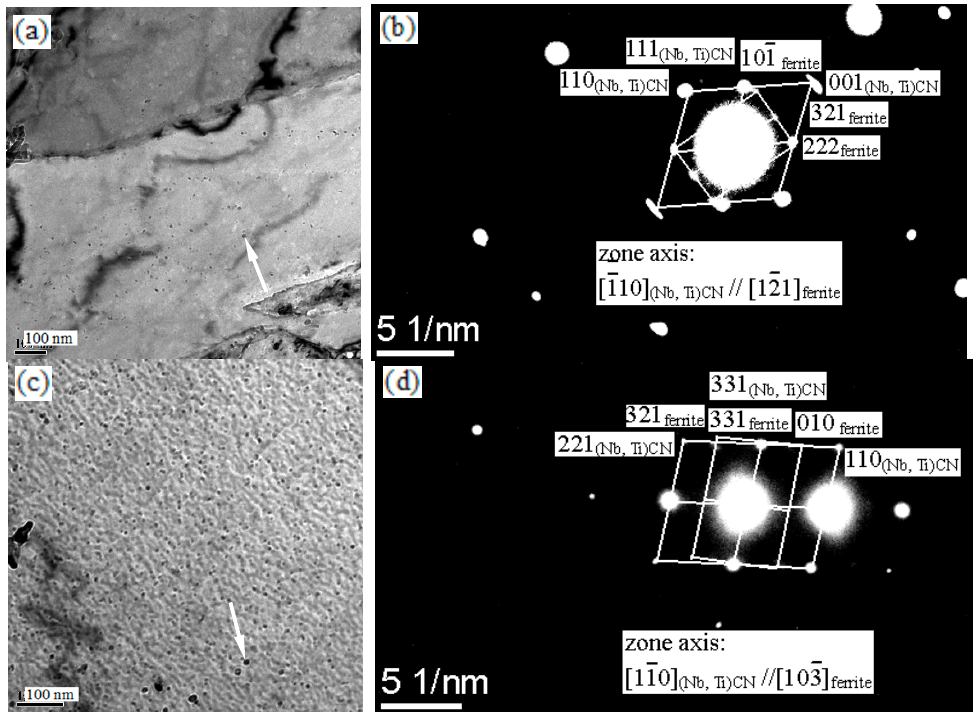
Figure 11. The presence of a dark precipitate (denoted by an arrow) particle and its schematic illustration of SAED held at ( a , b ) 600 °C; ( c , d ) 750 °C.